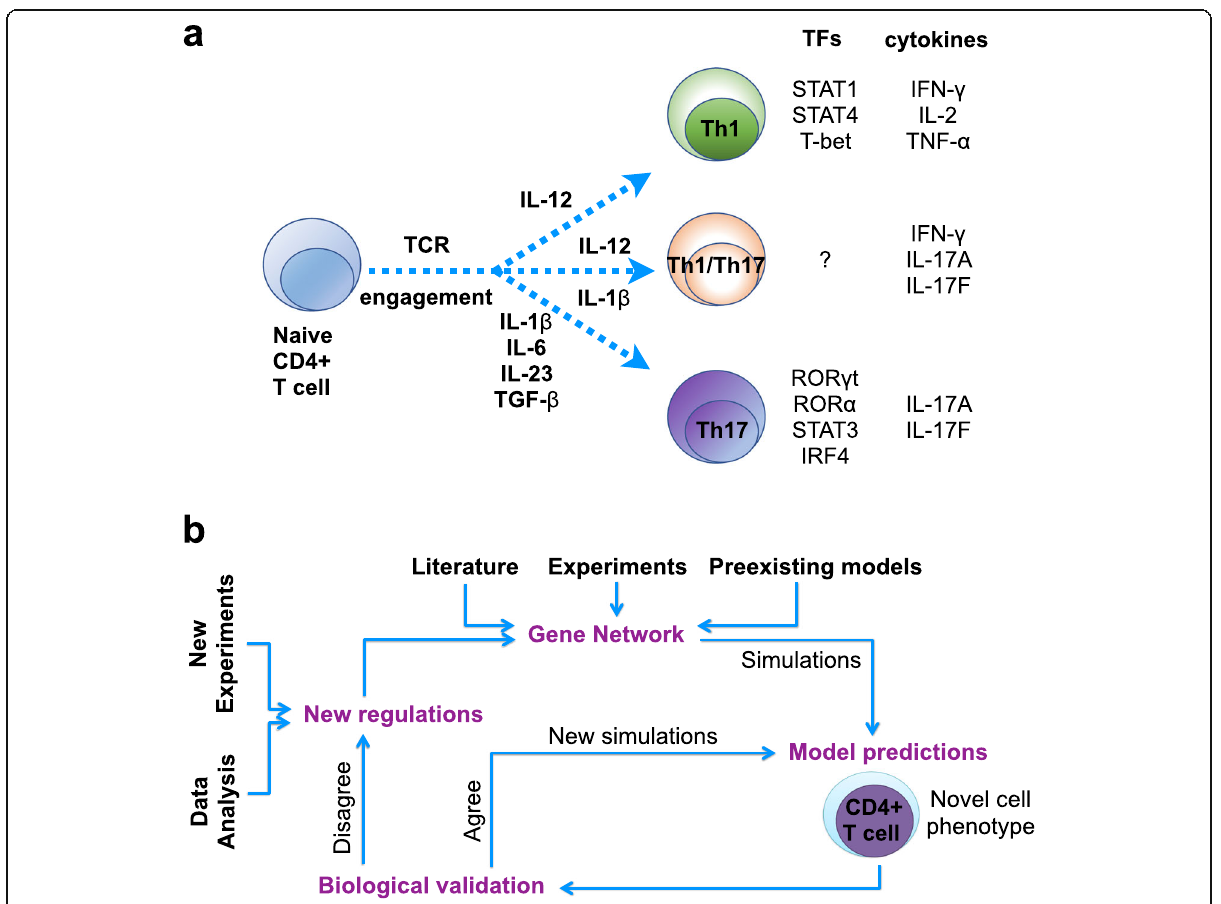
Fig. 1 Schematic overview of the experimental and computational workflow. a Schematic representation of Th1, Th17 and hybrid Th1-Th17 cell specification. TCR engagement, input cytokines, transcription factors and output cytokines are considered in a Th differentiation event. b Iterative modeling workflow. A model is first built based on information collected from publications, databases and previous models. This model is then used to predict dynamical behaviors (cell phenotype, differentiation, reprogramming, and so forth). Predictions are compared with experimental data; when the predictions and experimental data agree, further predictive simulations are performed; when they do not agree, further regulations are inferred from ChIP-seq and RNA-seq data, and are integrated into the model until simulations fully agree with biological data. TCR: T-cell receptor; TF: Transcription